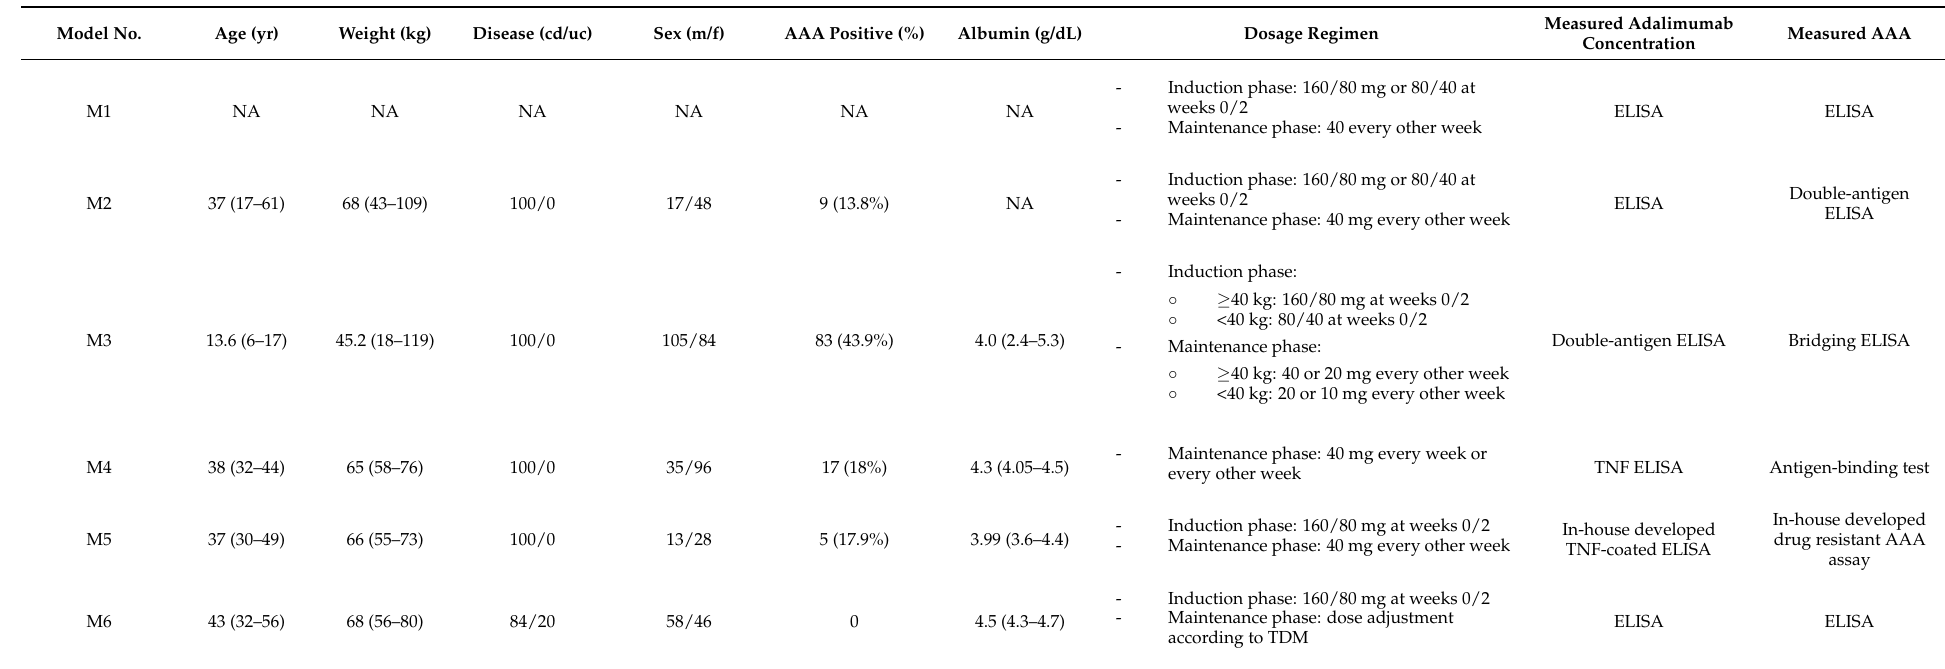
Table 2. Summary of patient characteristics of selected